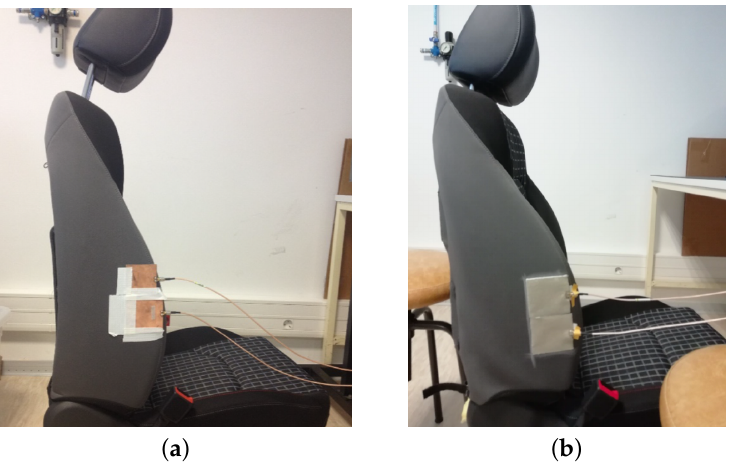
Figure 17. Position of the transmission (TX) and reception (RX) antennas, in the car seat, to acquire the respiratory signs: ( a ) conventional substrate antennas and ( b ) textile antennas.